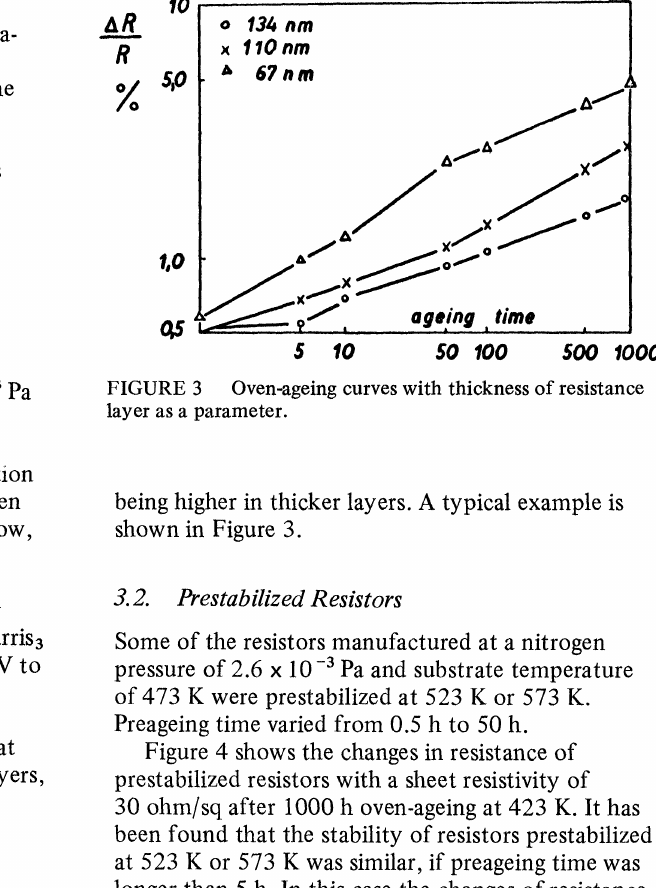
being higher in thicker layers. A typical example is shown in Figure 3.